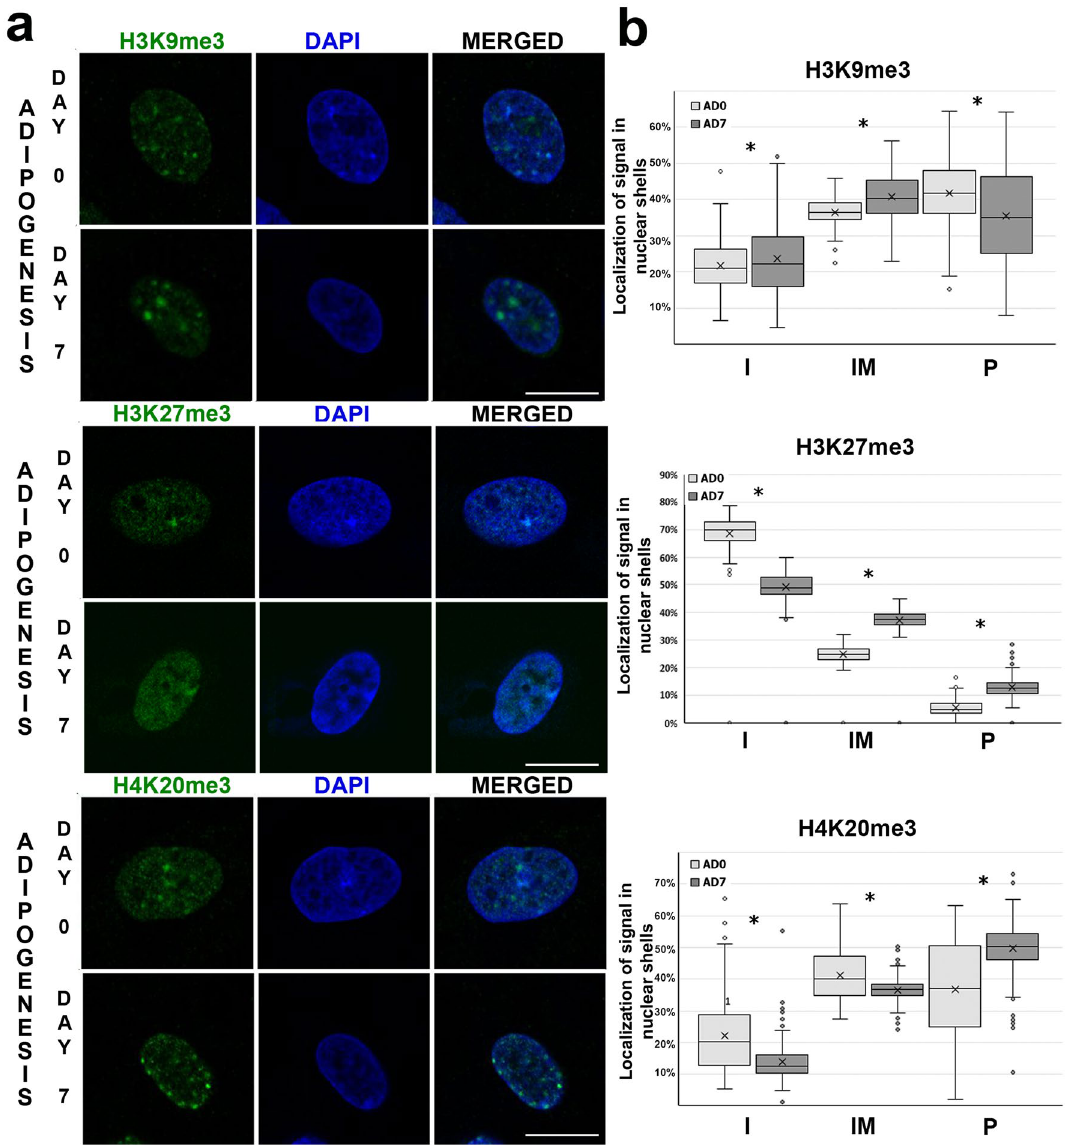
Figure 4. Spatial distribution of selected histone marks associated with heterochromatin. ( a ) Distribution of H3K9me3, H3K27me3, and H4K20me3 in a 3D nuclear space at days 0 and 7 of in vitro adipogenesis. The histone marks were visualized by indirect immunofluorescence (green). Nuclei were counterstained with DAPI (blue). Scale bar: 10 µm. ( b ) The graphs show spatial distribution of immunofluorescent signals in 3D nuclear space. Statistically significant differences ( P < 0.05) are marked with asterisks. Number of nuclei analyzed: H3K9me3: n = 497, H3K27me3: n = 243, H4K20me3: n = 604. Statistical data are shown in